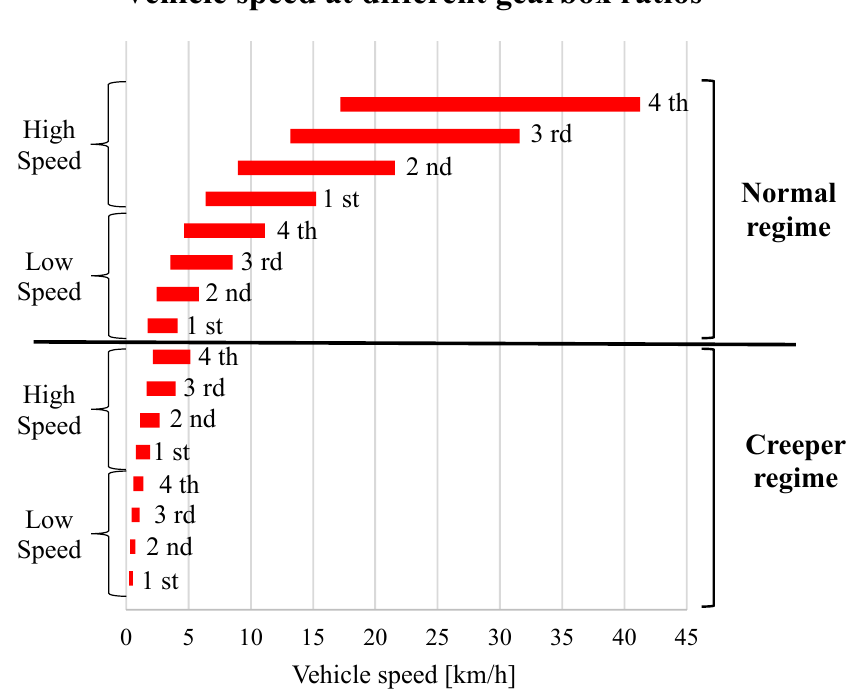
Figure 3. Typical speed distribution according to gearbox ratios.